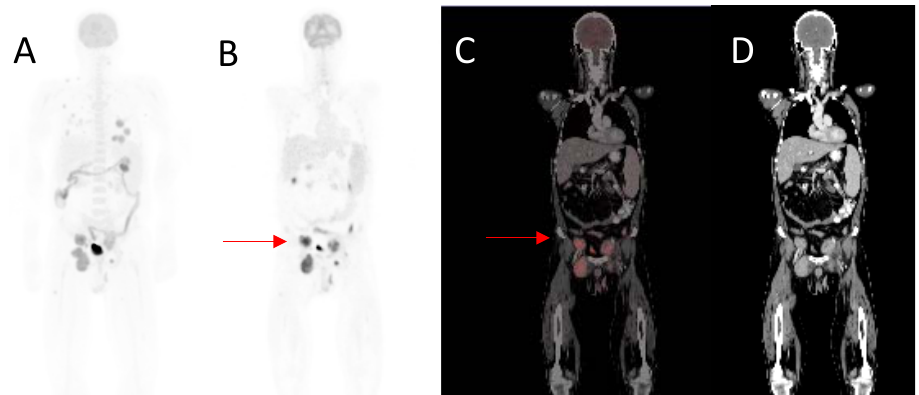
Figure 2. Kaplan–Meier curves for overall survival in restaging melanoma with respect to metabolic tumor volume (MTV) ( A ), whole-body MTV ( B ), total lesion glycolysis (TLG) ( C ), and whole-body TLG ( D ).